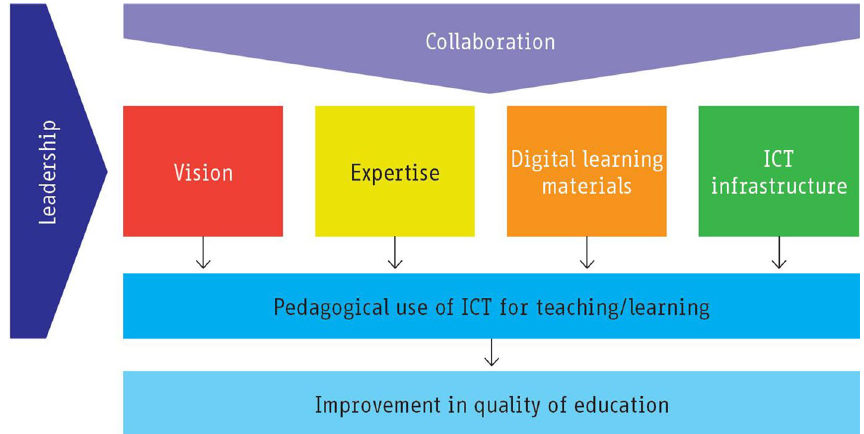
Fig. 2 The basic elements of the Four in Balance model (Source: Kennisnet (2011, p.11, as Figure 1.1 in the